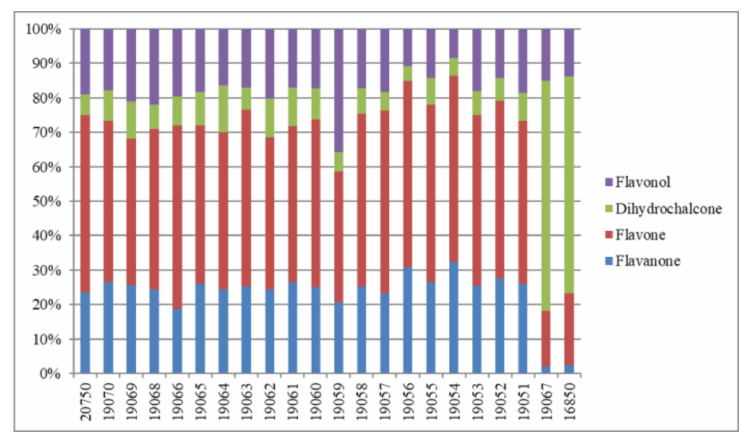
Figure 4. Percentage of flavonoid subclasses for compounds 2 – 14 to the total flavonoid content in authenticated plant sample (#16850) and dietary supplements (green rooibos tea #19067), and red rooibos tea (#19051, #19052, #19053, #19054, #19055, #19056, #19057, #19058, #19059, #19060, #19061, #19062, #19063, #19064, #19065, #19066, #19068, #19069, #19070, and #20750) at 288 nm.